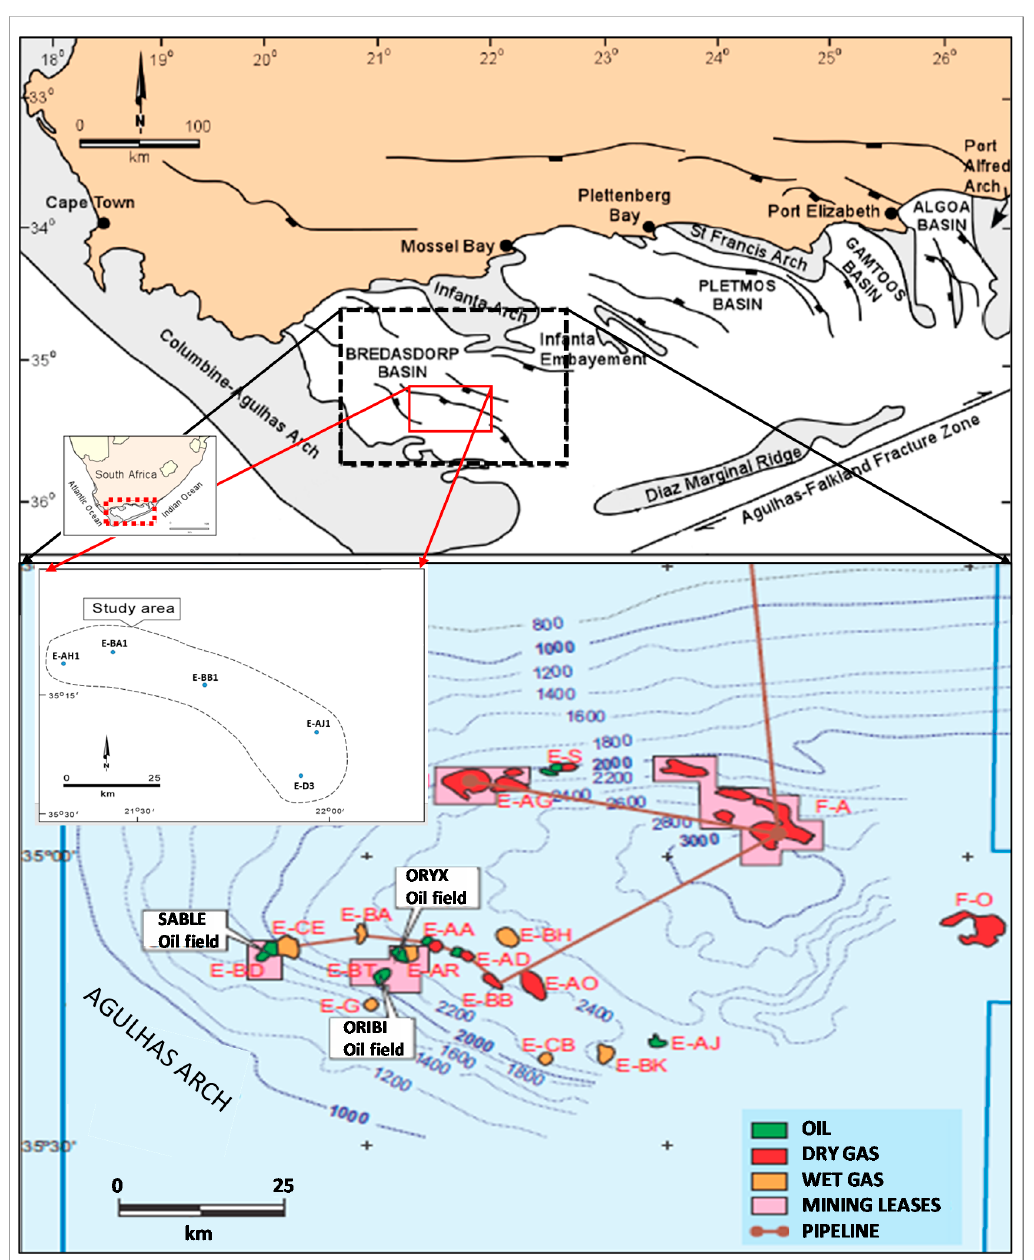
Figure 1. Map of the study area showing distribution of the exploration wells across the Bredasdorp Basin (modified from [42]).